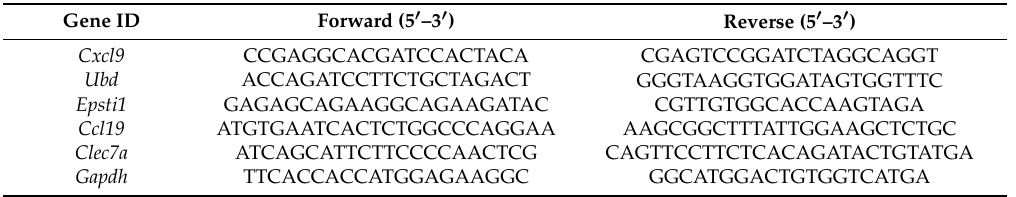
Table 4. Primer sequences for quantitative